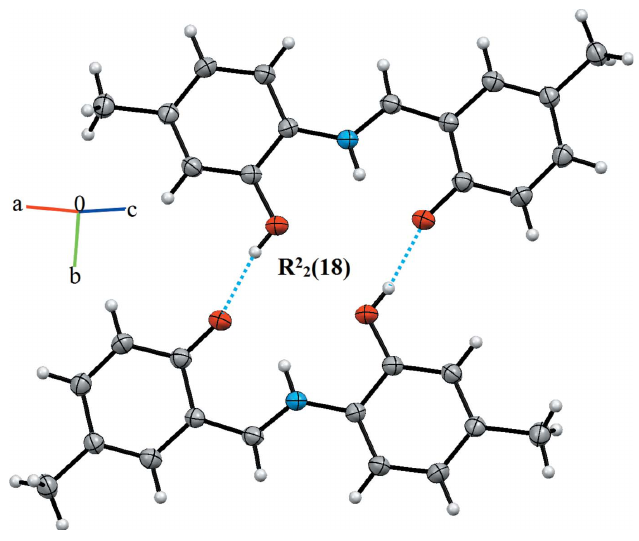
Figure 2 A view of the crystal packing of the title compound. Dashed lines denote